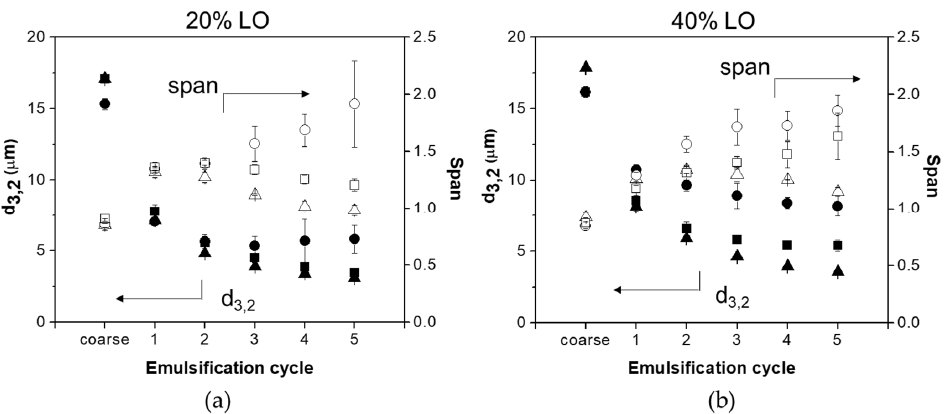
Figure 7. Sauter mean diameter (d 3,2 , full symbols) and span (empty symbols) versus the number Figure 6. Sauter mean diameter (d 3,2 , full symbols) and span (empty symbols) versus the number of emulsification cycles Figure 6. Sauter mean diameter (d 3,2 , full symbols) and span (empty symbols) versus the number of emulsification cycles Figure 6. Sauter mean diameter (d 3,2 , full symbols) and span (empty symbols) versus the number of emulsification cycles of emulsification cycles for produced LO (lemon oil) emulsions with 0.2 M phosphate buffer in the of emulsification cycles for produced LO (lemon oil) emulsions with 0.2 M phosphate buffer in the for emulsions at different oils and oil fractions: ( a ) 20% SO (sunflower oil); ( b ) 30% SO; ( c ) 40% SO; ( d ) 20% LO (lemon oil); for emulsions at different oils and oil fractions: ( a ) 20% SO (sunflower oil); ( b ) 30% SO; ( c ) 40% SO; ( d ) 20% LO (lemon oil); Figure 6. Sauter mean diameter (d 3,2 , full symbols) and span (empty symbols) versus the number of emulsification cycles for emulsions at different oils and oil fractions: ( a ) 20% SO (sunflower oil); ( b ) 30% SO; ( c ) 40% SO; ( d ) 20% LO (lemon oil); Figure 6. Sauter mean diameter (d 3,2 , full symbols) and span (empty symbols) versus the number of emulsification cycles Figure 6. Sauter mean diameter (d 3,2 , full symbols) and span (empty symbols) versus the number of emulsification cycles water phase at different oil fractions: ( a ) 20% LO and ( b ) 40% LO. ( d 3,2 -1 % WPI (whey protein ( e ) 30% LO; and ( f ) 40% LO. ( d 3,2 -1% WPI (whey protein isolate); d 3,2 -1% BSFPC (black soldier fly protein concentrate); ( e ) 30% LO; and ( f ) 40% LO. ( d 3,2 -1% WPI (whey protein isolate); d 3,2 -1% BSFPC (black soldier fly protein concentrate); for emulsions at different oils and oil fractions: ( a ) 20% SO (sunflower oil); ( b ) 30% SO; ( c ) 40% SO; ( d ) 20% LO (lemon oil); ( e ) 30% LO; and ( f ) 40% LO. ( d 3,2 -1% WPI (whey protein isolate); d 3,2 -1% BSFPC (black soldier fly protein concentrate); for emulsions at different oils and oil fractions: ( a ) 20% SO (sunflower oil); ( b ) 30% SO; ( c ) 40% SO; ( d ) 20% LO (lemon oil); for emulsions at different oils and oil fractions: ( a ) 20% SO (sunflower oil); ( b ) 30% SO; ( c ) 40% SO; ( d ) 20% LO (lemon oil); span-2% BSFPC). ( e ) 30% LO; and ( f ) 40% LO. ( d 3,2 -1% WPI (whey protein isolate); d 3,2 -2% BSFPC; span-1%WPI; span-1% BSFPC; span-2% BSFPC). d 3,2 -2% BSFPC; span-1%WPI; span-1% BSFPC; span-2% BSFPC). ( e ) 30% LO; and ( f ) 40% LO. ( d 3,2 -1% WPI (whey protein isolate); d 3,2 -1% BSFPC (black soldier fly protein concentrate); ( e ) 30% LO; and ( f ) 40% LO. ( d 3,2 -1% WPI (whey protein isolate); d 3,2 -1% BSFPC (black soldier fly protein concentrate); d 3,2 -2% BSFPC; d 3,2 -2%